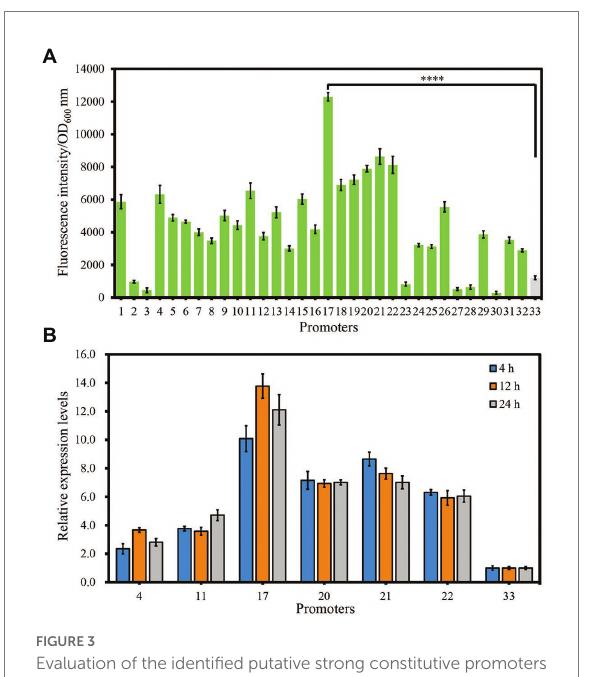
FIGURE 3 Evaluation of the identified putative strong constitutive promoters in strain JNB5-1 via eGFP reporter and RT-qPCR analysis. (A) Evaluation of the selected promoters using an eGFP reporter. (B) RT-qPCR assays of the selected promoters. The promoters 1, 2, 3, 4, 5, 6, 7, 8, 9, 10, 11, 12, 13, 14, 15, 16, 17, 18, 19, 20, 21, 22, 23, 24, 25, 26, 27, 28, 29, 30, 31, 32, and 33 indicates the promoter of the ahpC , clpP , cpxP , cspC , eno , ftsZ , gltA , lpp , lpxC , nlpI , ompA , ompC , ompN , ompW , ompX , raiA , rplJ , rpoB , rpoH , rpsA , rpsF , rpsM , SMWW4_v1c12140 , SMWW4_v1c29250 , sodB , tpiA , trxA , uspG , ybaY , yccA , yfiD , ygdI , and bla gene, respectively. For (A) and (B) , the experiment was performed independently three times. Error bars indicate standard deviations. One-way analysis of variance (ANOVA) was used to examine the mean differences between the data groups. **** p < 0.001.